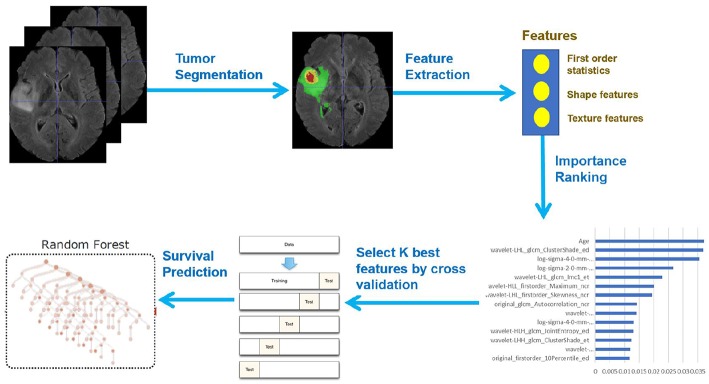
Framework overview.